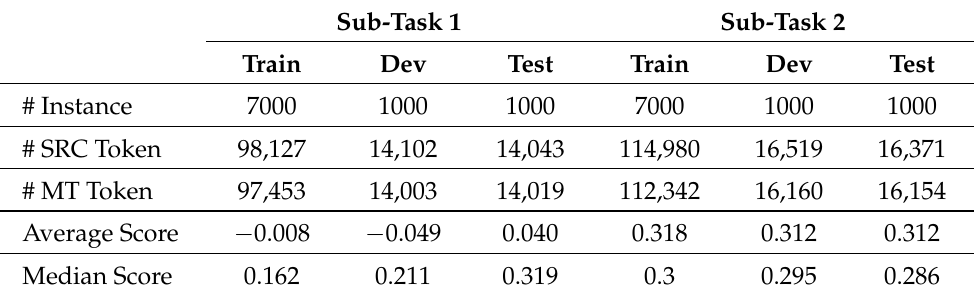
Table 1. Summary of the QE dataset. We denote the number of instances in each dataset as # Instance. # SRC Token and # MT Token refer to the number of tokens in source- and target-side sentences for each dataset,